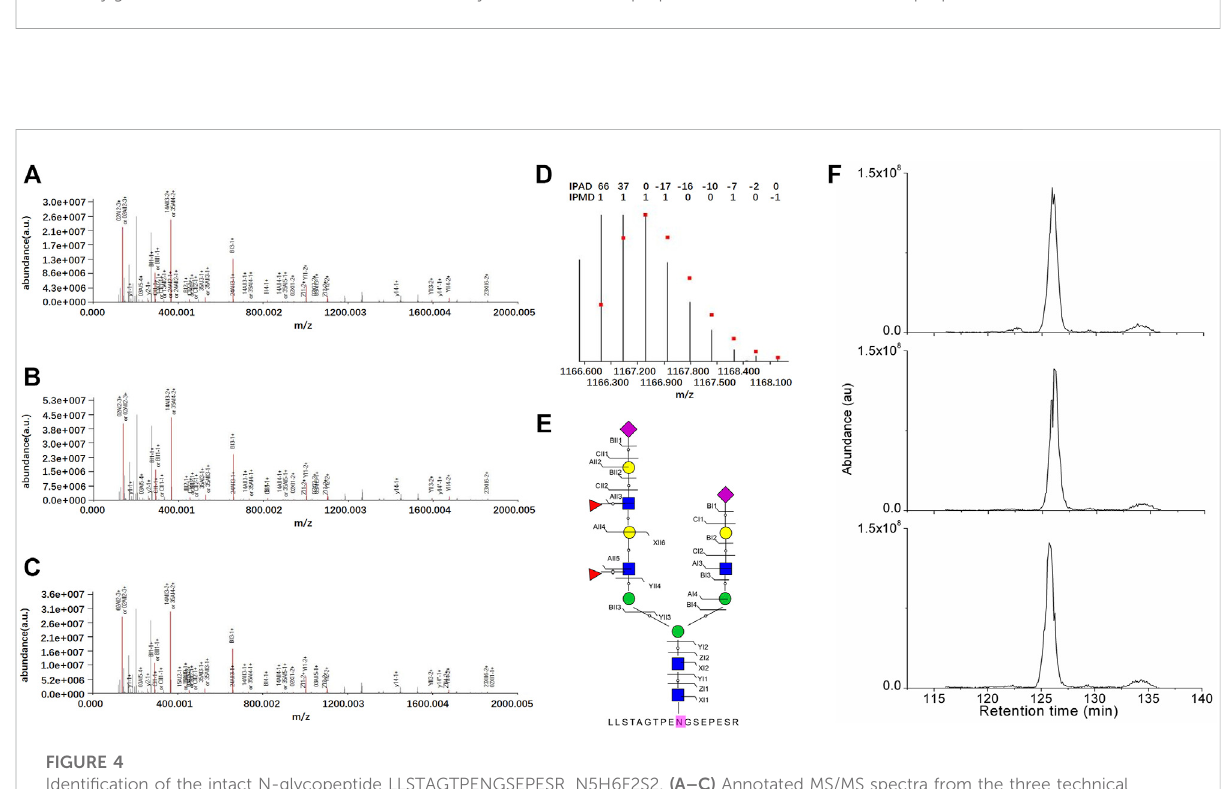
FIGURE 4 Identi fi cation of the intact N-glycopeptide LLSTAGTPENGSEPESR_N5H6F2S2. (A – C) Annotated MS/MS spectra from the three technical replicate RPLC-MS/MS runs; (D) fi ngerprinting map of the experimental (bar) and theoretical (dot) isotopic envelopes of the precursor ion; (E) graphical fragmentation map of the N-glycan moiety; and (F) extracted ion chromatograms of the precursor ion from the three technical replicate RPLC-MS/MS runs. =N-acetylglucosamine (Y); =mannose (M); = galactose (L); =sialic acid (S); = fucose (F) ; au = arbitrary unit; IPMD = isotopic peak m/z deviation; IPAD = isotopic peak abundance